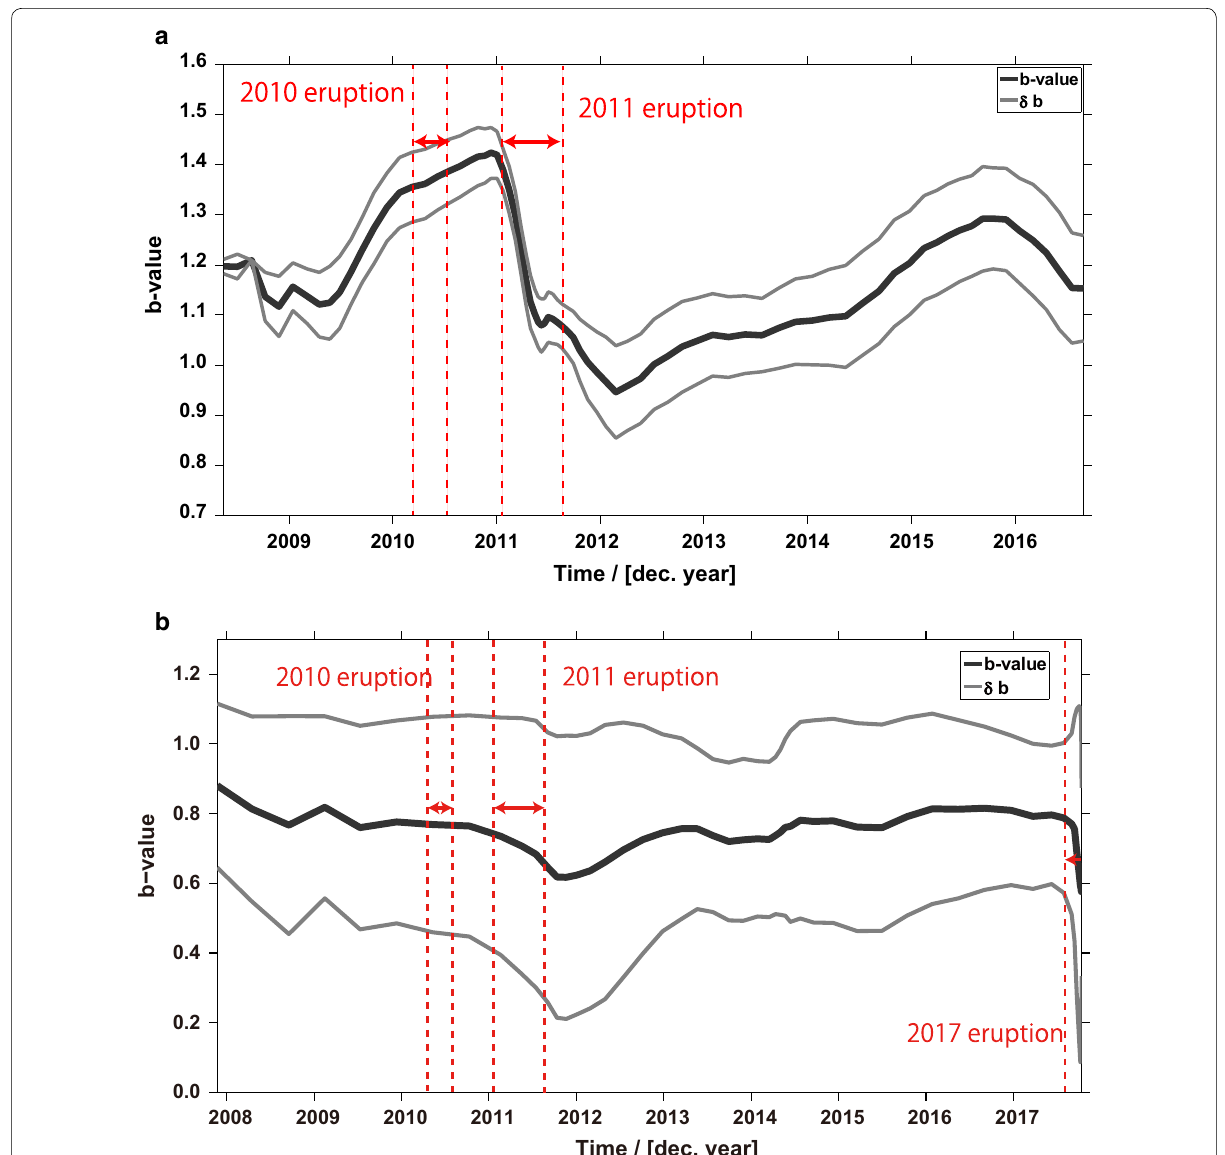
Fig. 3 Temporal distribution of b -values a beneath (region A) and b in the region 7.0–8.0 km northwest of the summit (region B). Gray lines show the standard deviation in the calculated b -values. Red broken lines indicate the start and end times of the 2010 and 2011